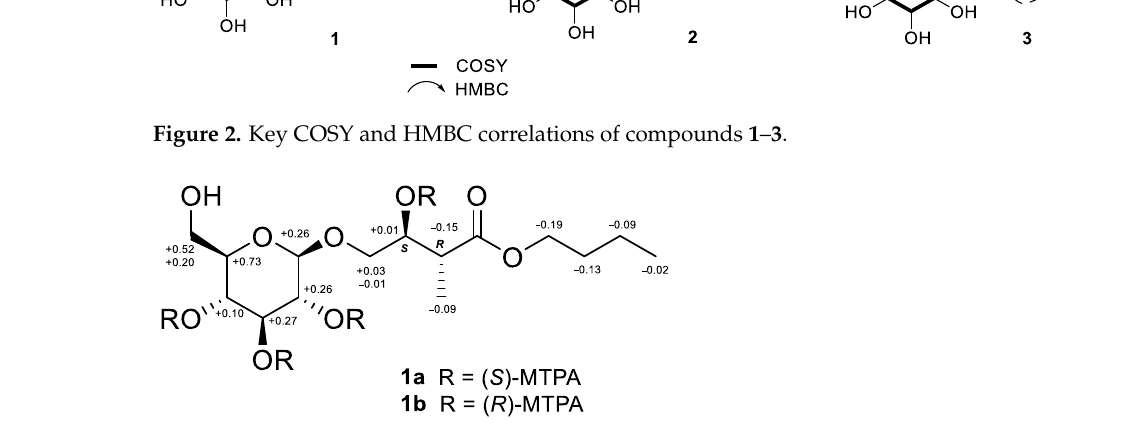
Figure 3. 1 H NMR chemical shift differences [ δ ( S )-MTPA— δ ( R )-MTPA] of the MTPA esters 1a and 1b .